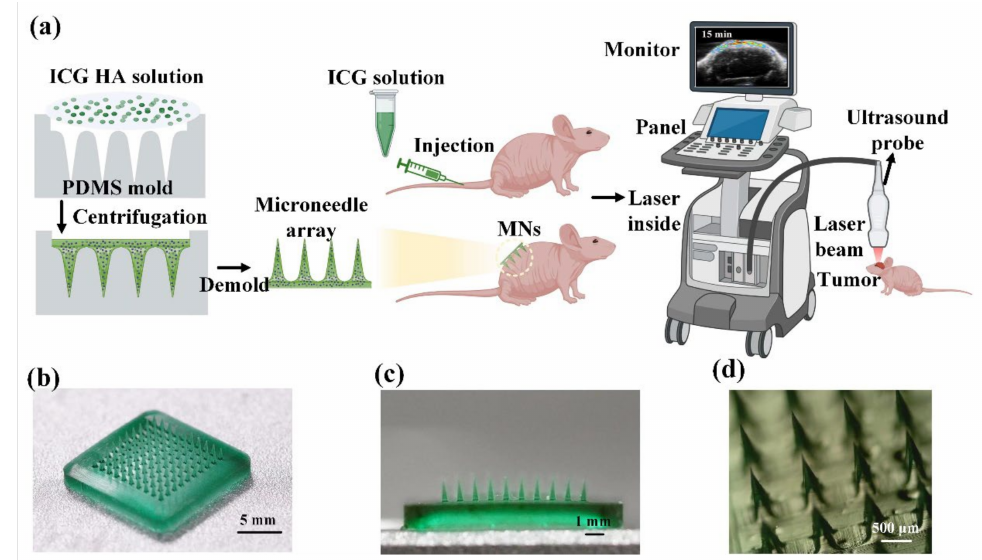
Figure 1. ( a ) Schematic of the fabrication process of ICG-HA-MNs and an illustration of the experi- mental procedure. ( b ) Photography of ICG-HA-MNs patch in full view. ( c ) Cross-sectional view of the ICG-HA-MNs patch. ( d ) Stereomicroscopy image of the